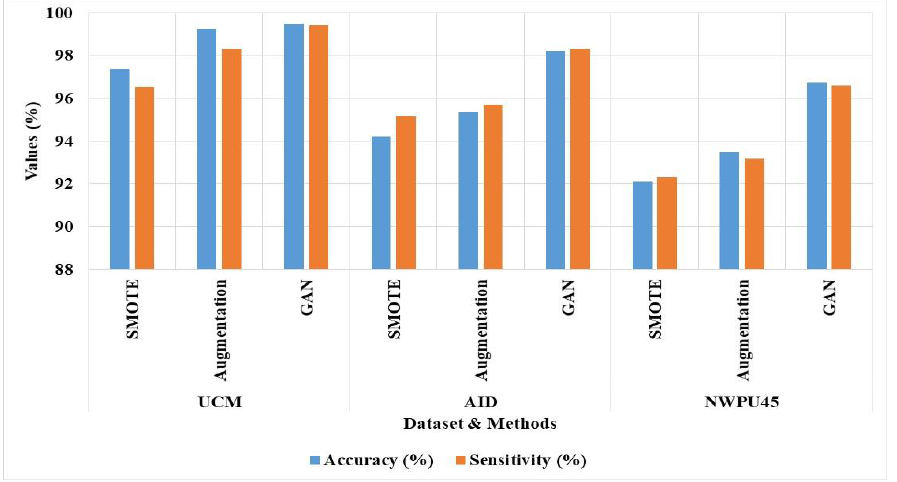
Figure 14. GM-SMO performance in the sampling process.